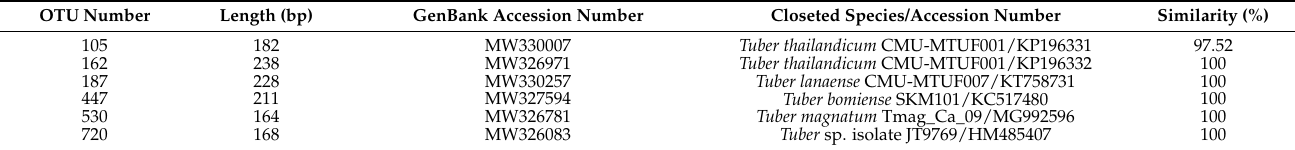
Table 2. Detail of the DNA sequences of Tuber species obtained from soil using metabarcoding. OTU